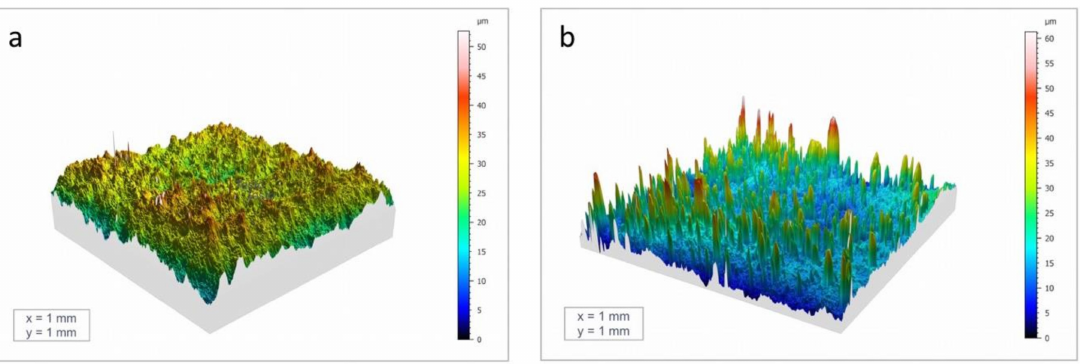
Figure 6. Three-dimensional surface topography of the uncoated implant ( a ) and the sphene-coated implant ( b